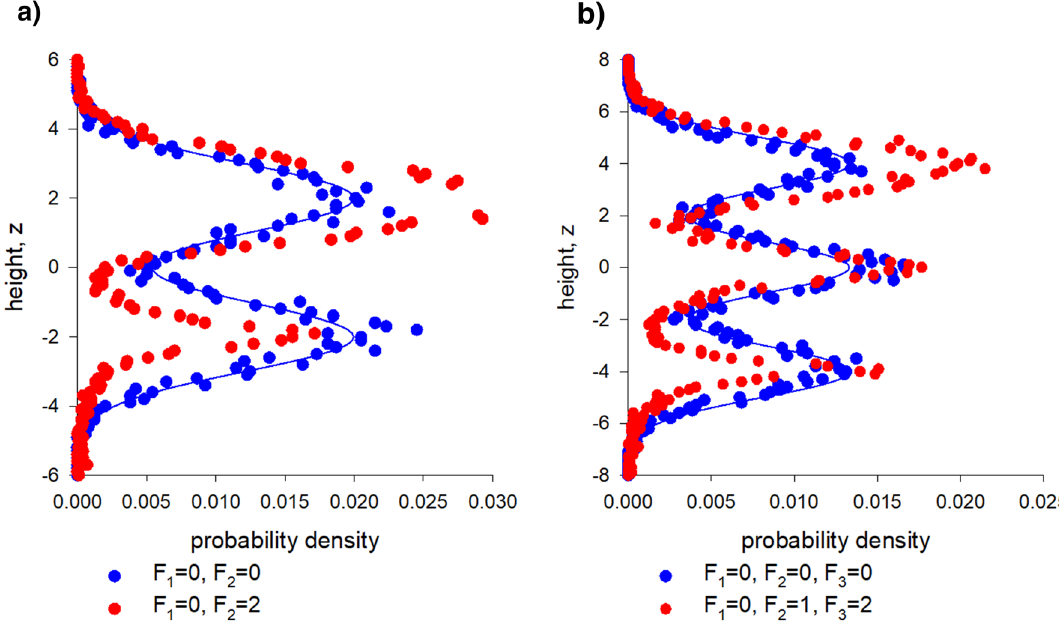
Figure 7. Intrinsic noise causes compression and de-population of lower sublayers. In the absence of intrinsic noise, distributions of simulated individuals (•) match theoretical expectations (solid line) for noiseless swarms. The presence of noise in the lower sub-layers reduces their size and causes partially de-populate. Predictions are shown for the stochastic model, Eq. (4) ( a ) and its generalization to 3 sublayers ( b ).